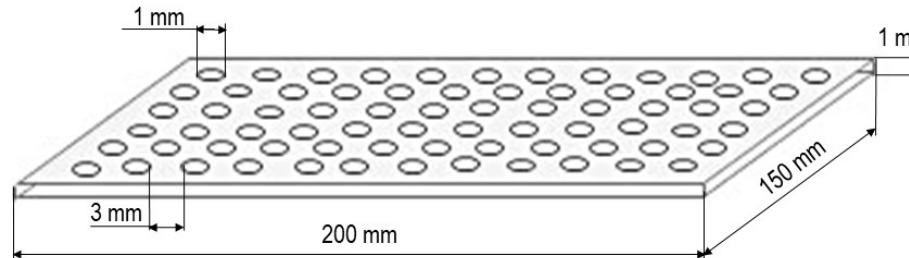
Figure 1. The developed geometric stencil.